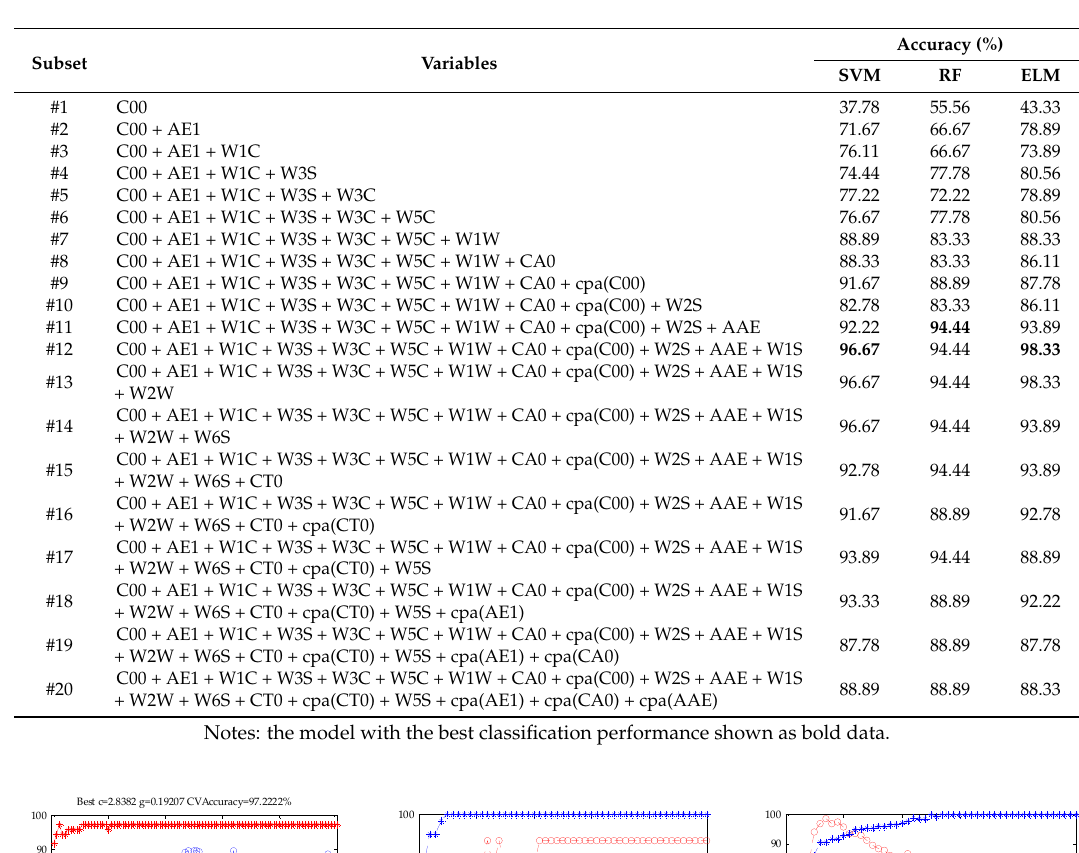
Table 4. Comparison of accuracy based on different classification models using different subsets of variables, based on VIP.